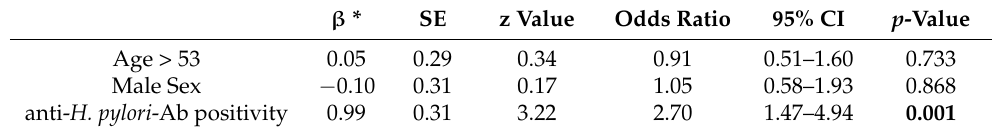
Table 3. Multivariate analysis of factors according to the competency of the pylorus.